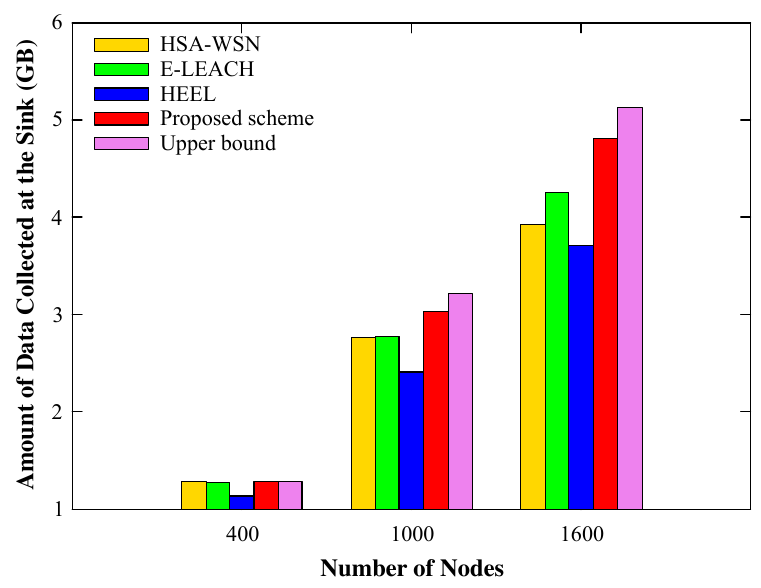
Figure 10. The amount of gathered data according to the number of